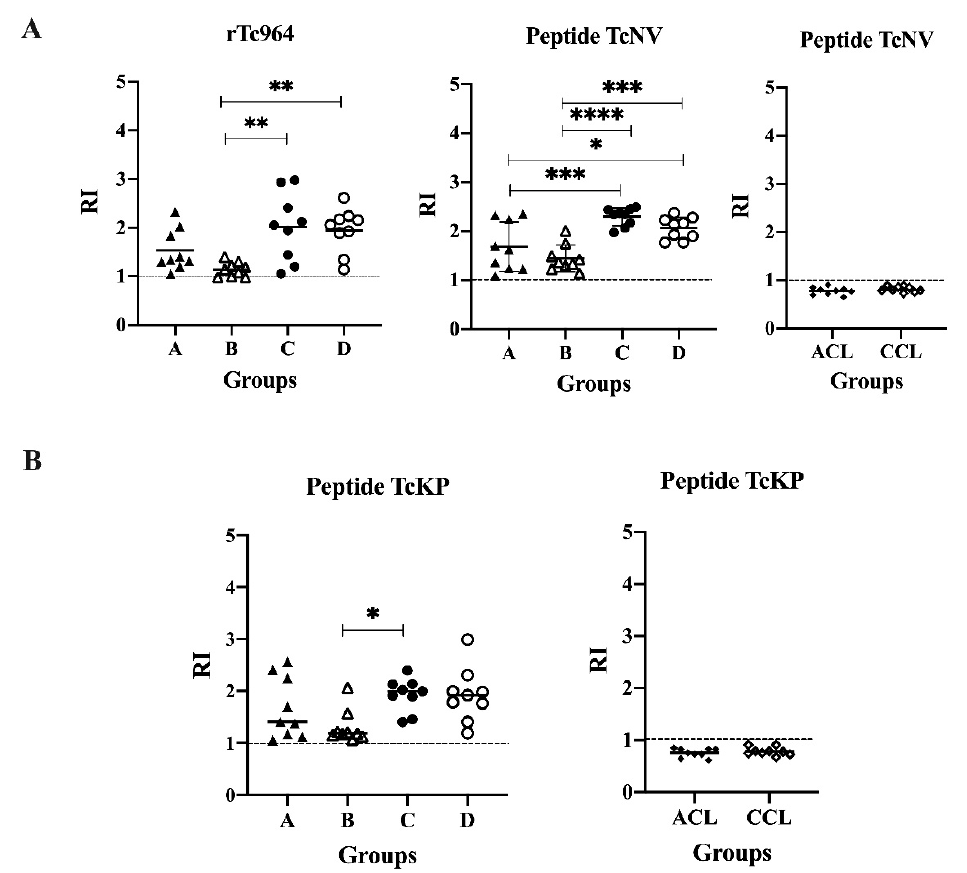
Figure 6. Antigenicity of the TcNV and TcKP peptides. ( A ) ELISA test, using the TcNV peptide and sera from patients at di ff erent stages of CCD and sera of ACL and CCL patients. The rTc964 protein was used as positive control. ( B ) ELISA test, using TcKP as antigen and as primary antibody sera from patients with CCD with di ff erent stages and sera of ACL and CCL patients. The RI values shown in the figures correspond to the average of three (3) replicas. The p values were calculated using one-way ANOVA nonparametric Kruskal–Wallis (ns p > 0.05, * p < 0.05, ** p < 0.01) for the rTc964, TcKP peptide vs CCD sera; one-way ANOVA Fisher’s LSD test (ns p > 0.05, * p < 0.05, *** p < 0.001, **** p < 0.0001) for the TcNV peptide vs CCD sera and the significance between two groups was calculated using the Mann-Whitney U test for both peptides vs ACL, CCL sera.